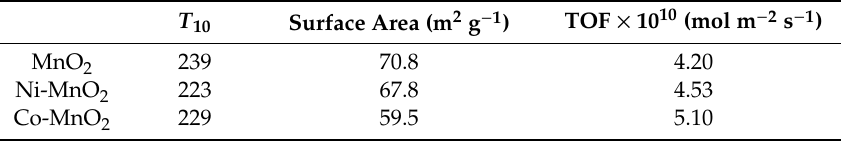
Table 1. The surface areas and TOFs of the three catalysts.